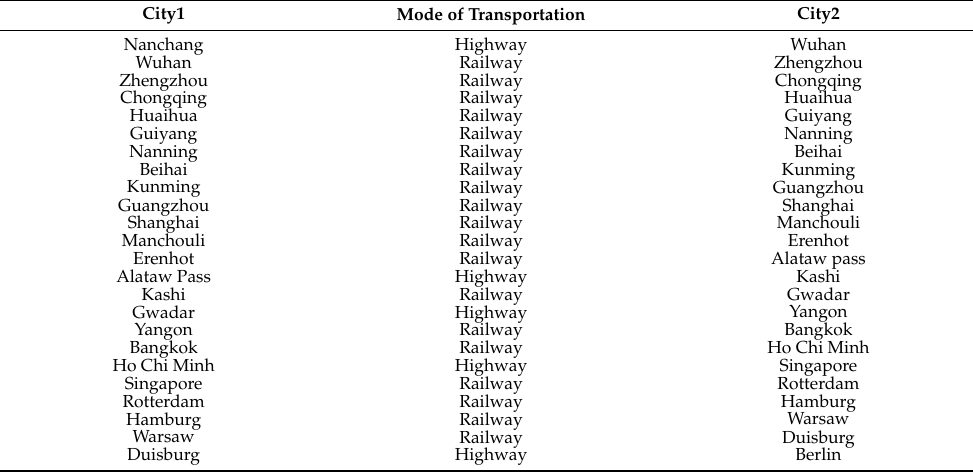
Figure 10. GA algorithm carbon emissions target iteration curve. Table 7. General GA algorithm to optimize the optimal path of multimodal